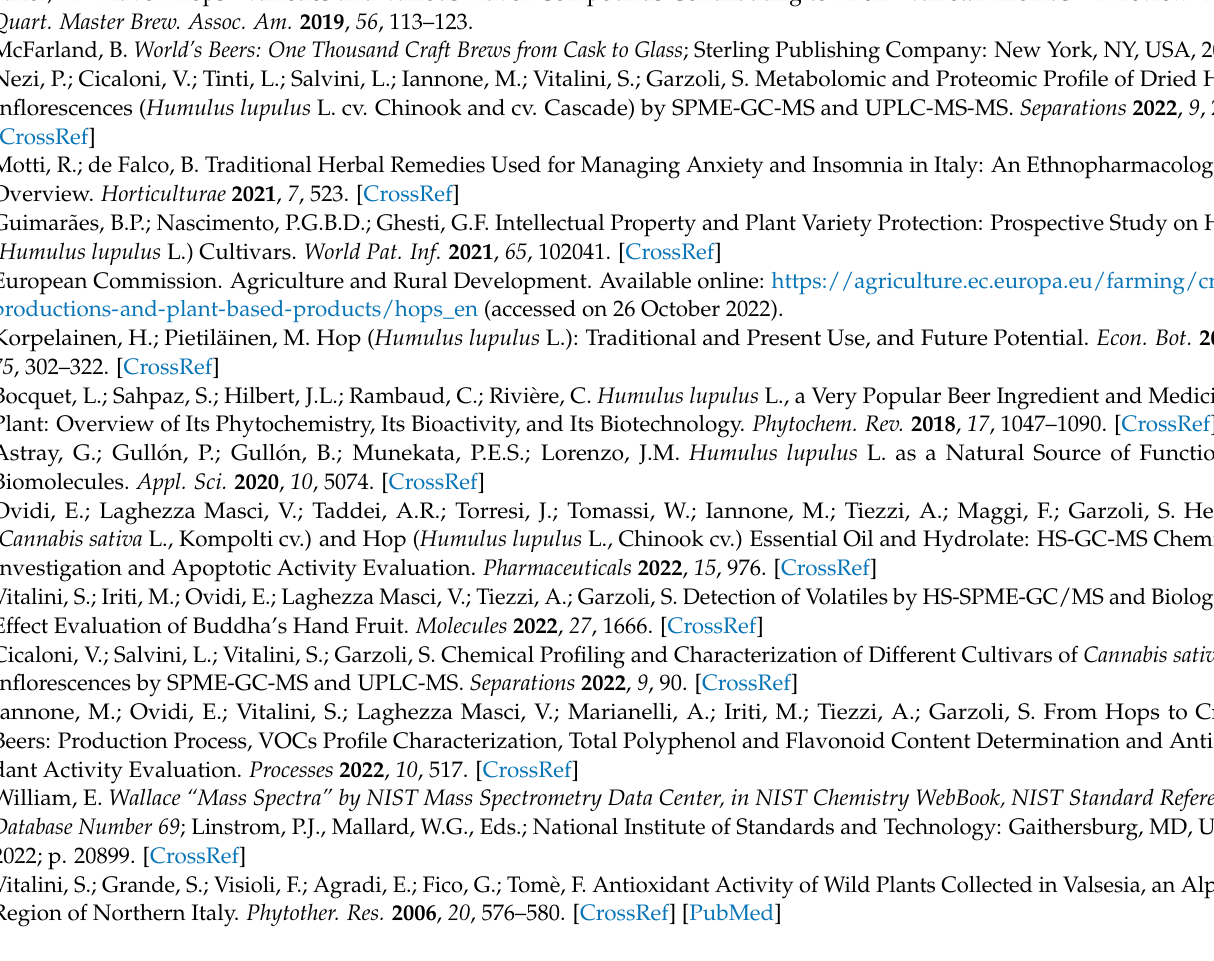
Figure S16: Hop rhizome transplant; Figure S17: Planting layout and irrigation method; Figure S18: Late hop flowering phase; Figure S19: View of plants in full bloom; Figure S20: Hop inflorescence collection; Figure S21: Harvested hop with the presence of lupulin; Figure S22: Fresh material packaging; Table S1: Tentative determined